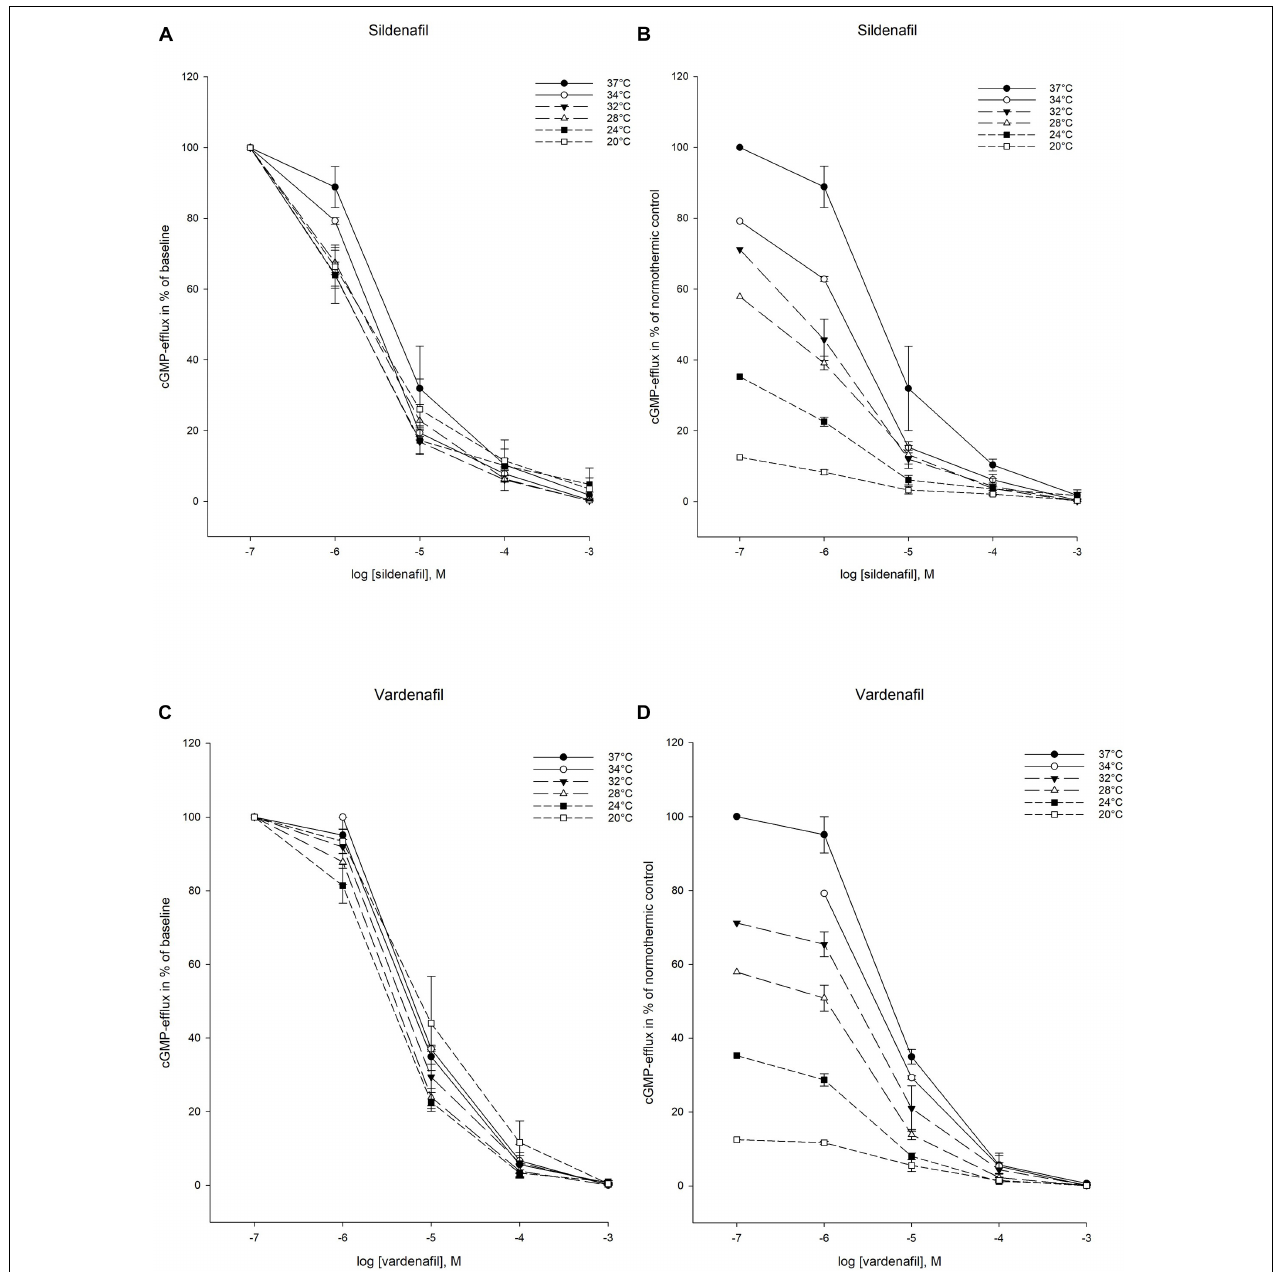
FIGURE 3 | Temperature-dependent inhibition of cGMP-efflux in inside-out vesicles (IOV). (A) Sildenafil inhibition curves for ABCC5-activity at temperatures ranging from 37 ◦ C to 20 ◦ C. The doses of sildenafil are in logarithm of the concentration in mol/L. (B) Inhibition curves for ABCC5-activity by sildenafil in % of normothermic inhibition curve at temperatures ranging from 37 ◦ C to 20 ◦ C. The doses of sildenafil are in logarithm of the concentration in mol/L. (C) Vardenafil inhibition curves for ABCC5-activity at temperatures ranging from 37 ◦ C to 20 ◦ C. The doses of vardenafil are in logarithm of the concentration in mol/L. (D) Inhibition curves for ABCC5-activity by vardenafil in % of normothermic inhibition curve at temperatures ranging from 37 ◦ C to 20 ◦ C. The doses of vardenafil are in logarithm of the concentration in